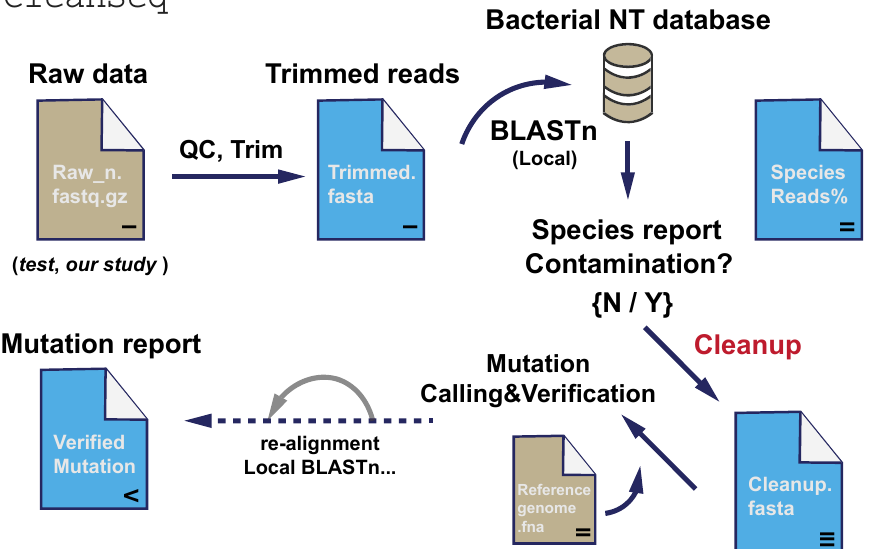
Figure 1. Schematic design and data processing flow of CleanSeq pipeline. Raw data from genome DNA sequencing are directly introduced, verified by quality check (QC), and trimmed accordingly. The trimmed reads are then analyzed in a local bacterial nucleotide (NT) database. The species and contamination information are determined based on the percentage of the reads of each species out of all reads. The reads are then cleaned up and proceeded as a cleanup file, further subjected to mutation calling. The called mutations are further verified via re-alignment, visualization, and manual comparisons. The finalized report file containing species contamination and confirmed mutations is generated.